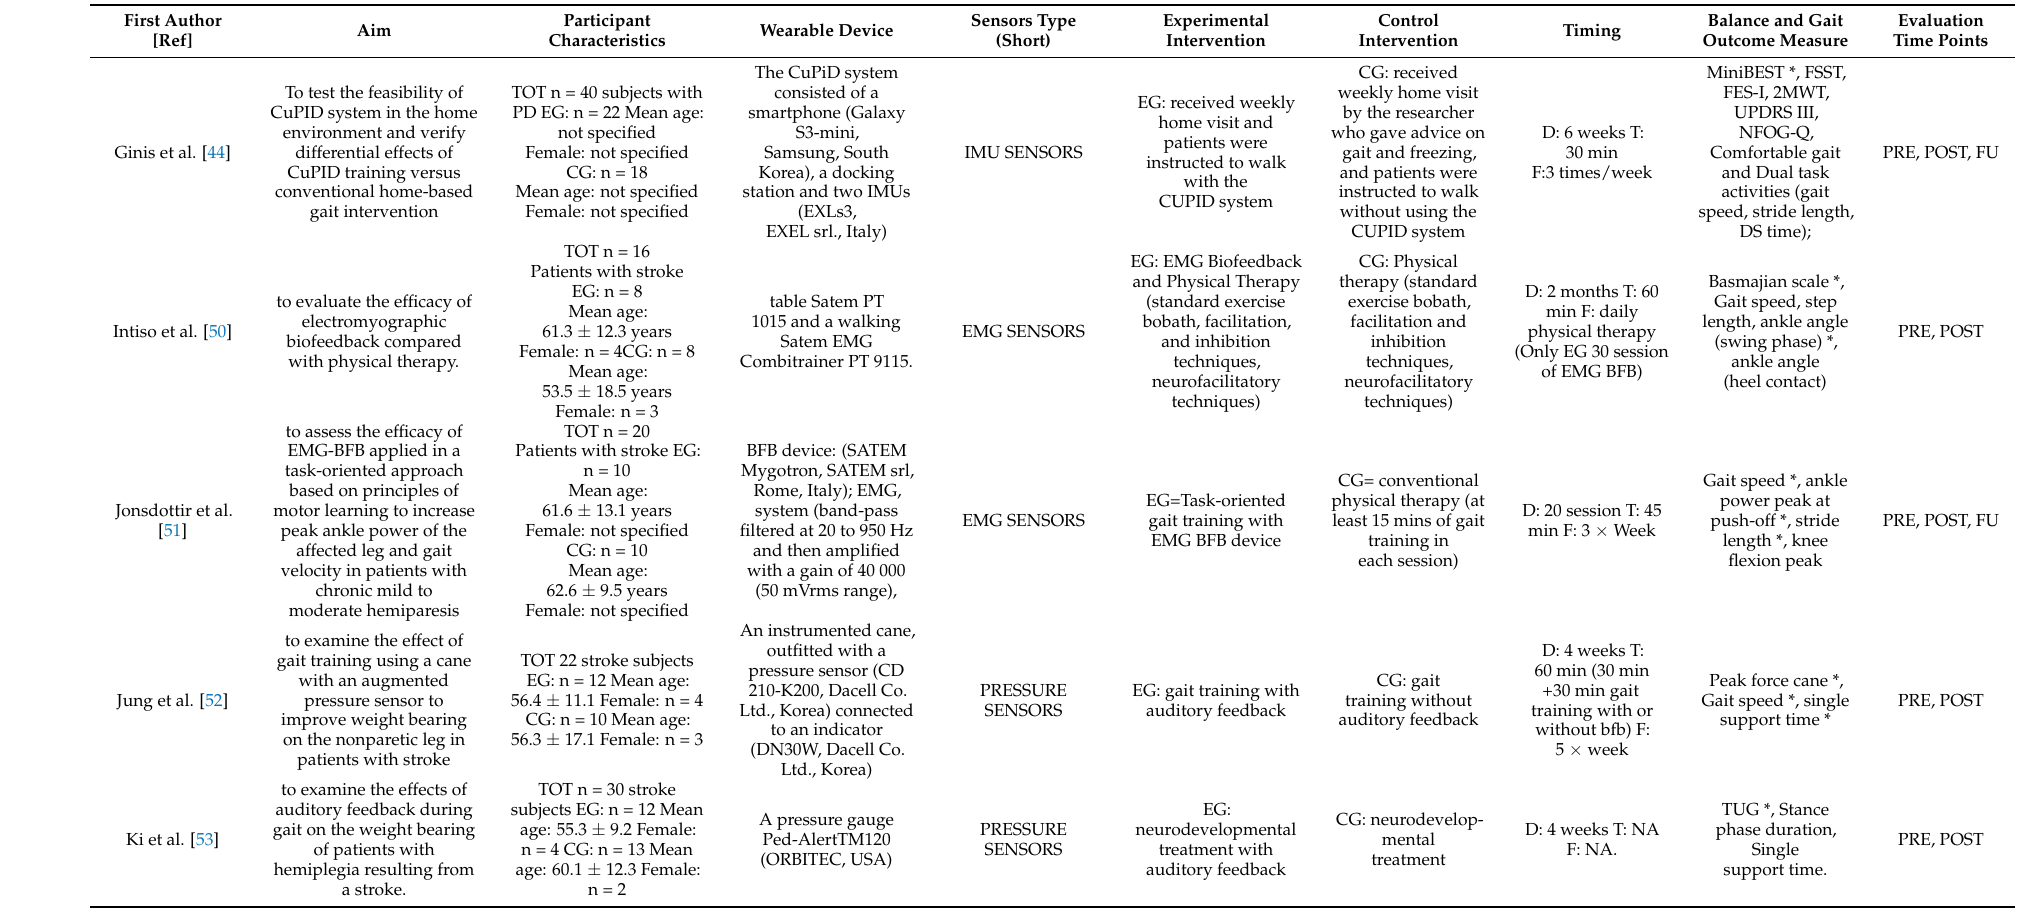
Satem EMG Combitrainer PT